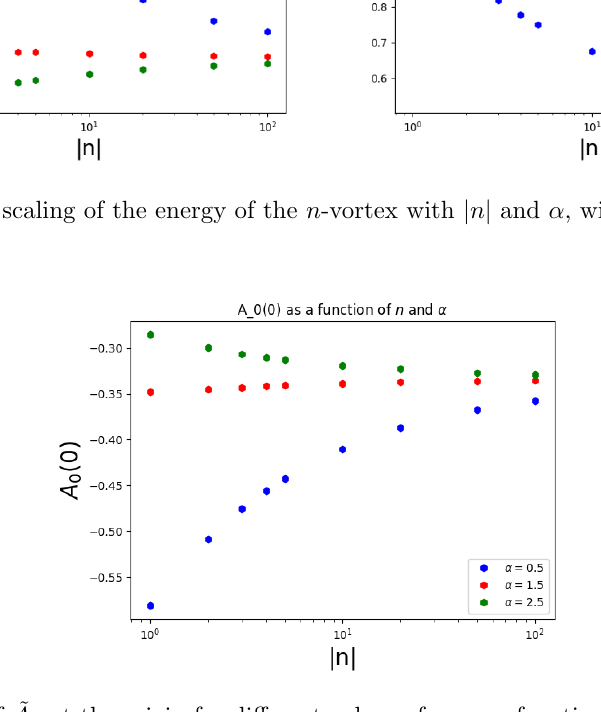
Figure 12 . Value of ~ A 0 at the origin for di(cid:11)erent values of (cid:11) , as a function of j n j , with the sextic